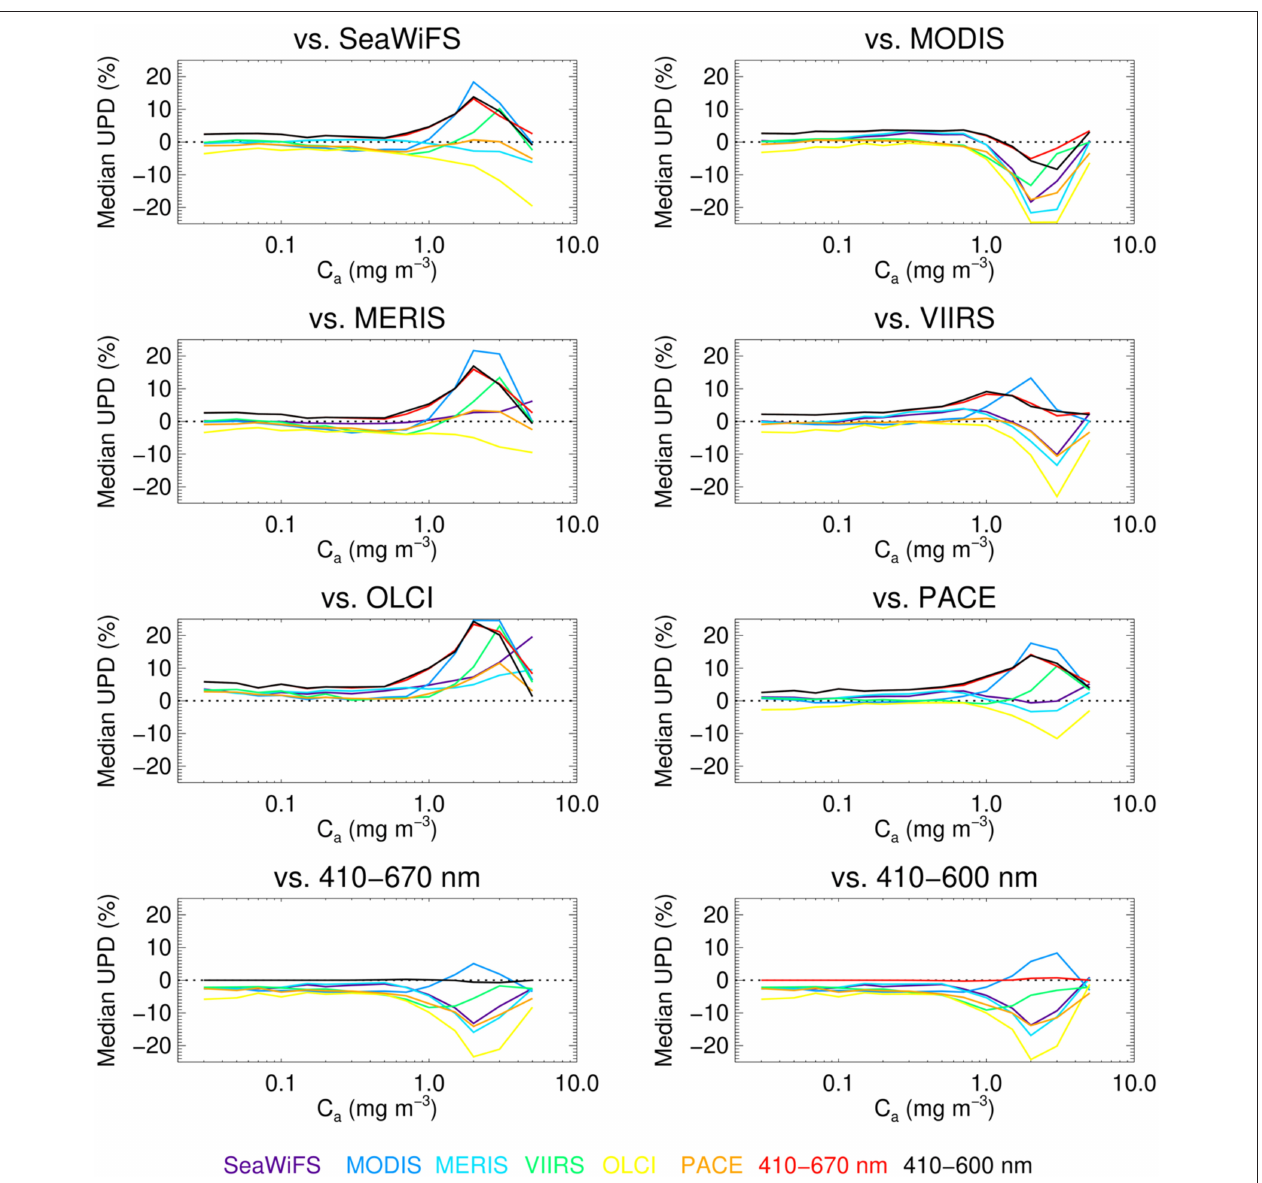
FIGURE 10 | As for Figure 9 , but for a dg